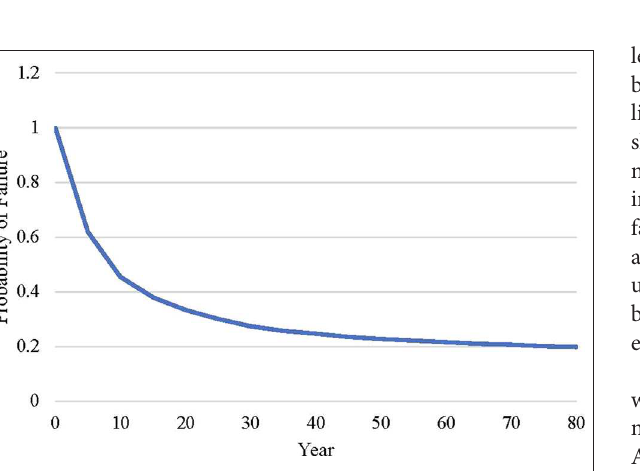
FIGURE 3 | Simulation based probability of failure at 5 year intervals for 0.04 and 0.08 m